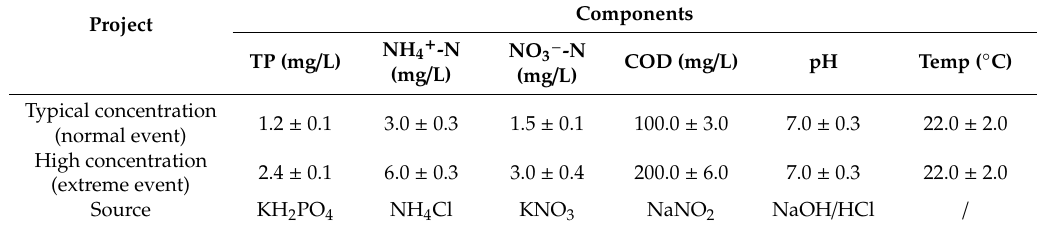
Table 2. Two types of concentrations for synthetic runo ff used in this study.